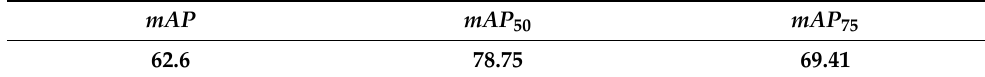
Table 4. AP value of the experiment.